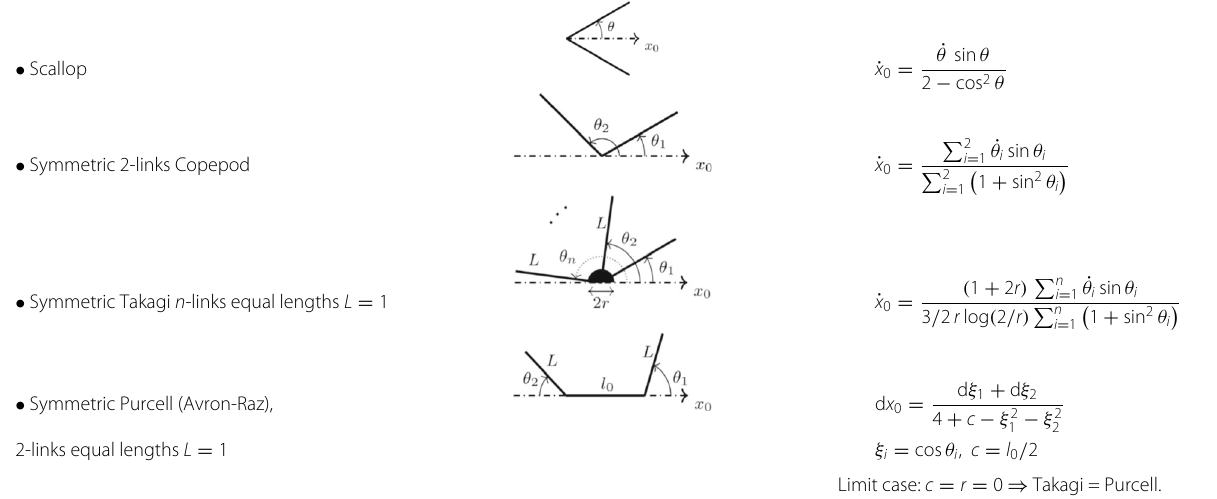
Table 1 Models of symmetric swimmer encountered in the